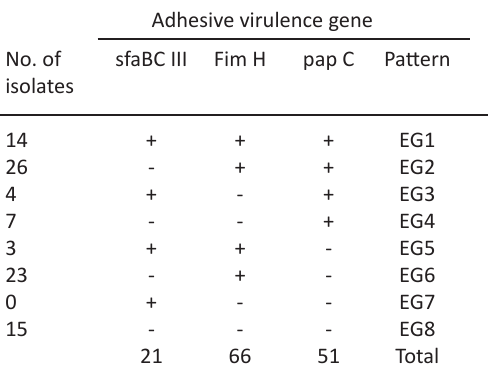
Table 5. Pattern of Adhesive virulance gene in E. coli Adhesive virulence